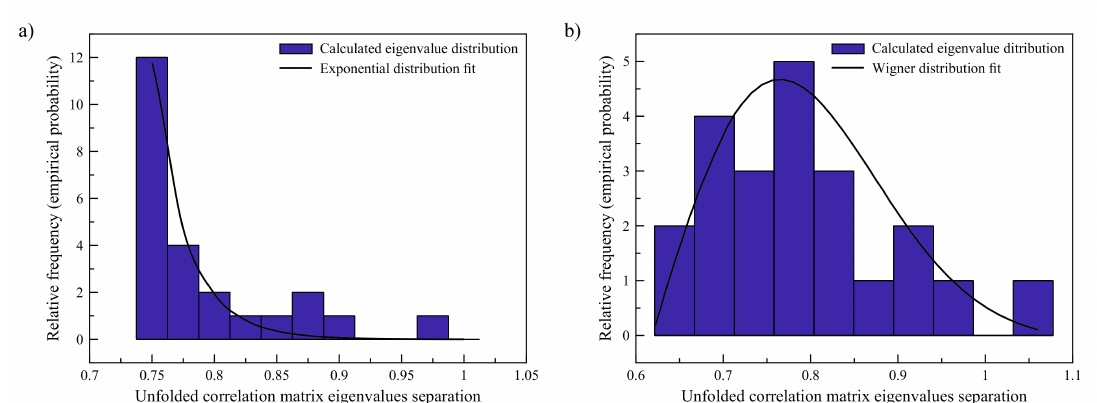
Figure 1. ( a ) Calculated eigenvalue separation distribution histogram for the “quiet” part of the data with fitted exponential distribution; ( b ) calculated eigenvalue separation distribution histogram for the “active” part of the data with fitted Wigner